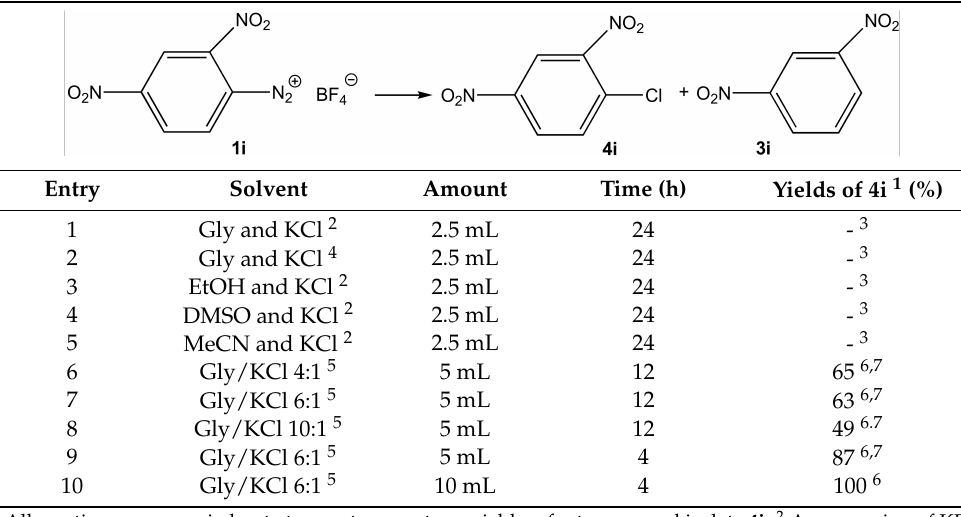
Table 5. Chlorodediazotation: trial